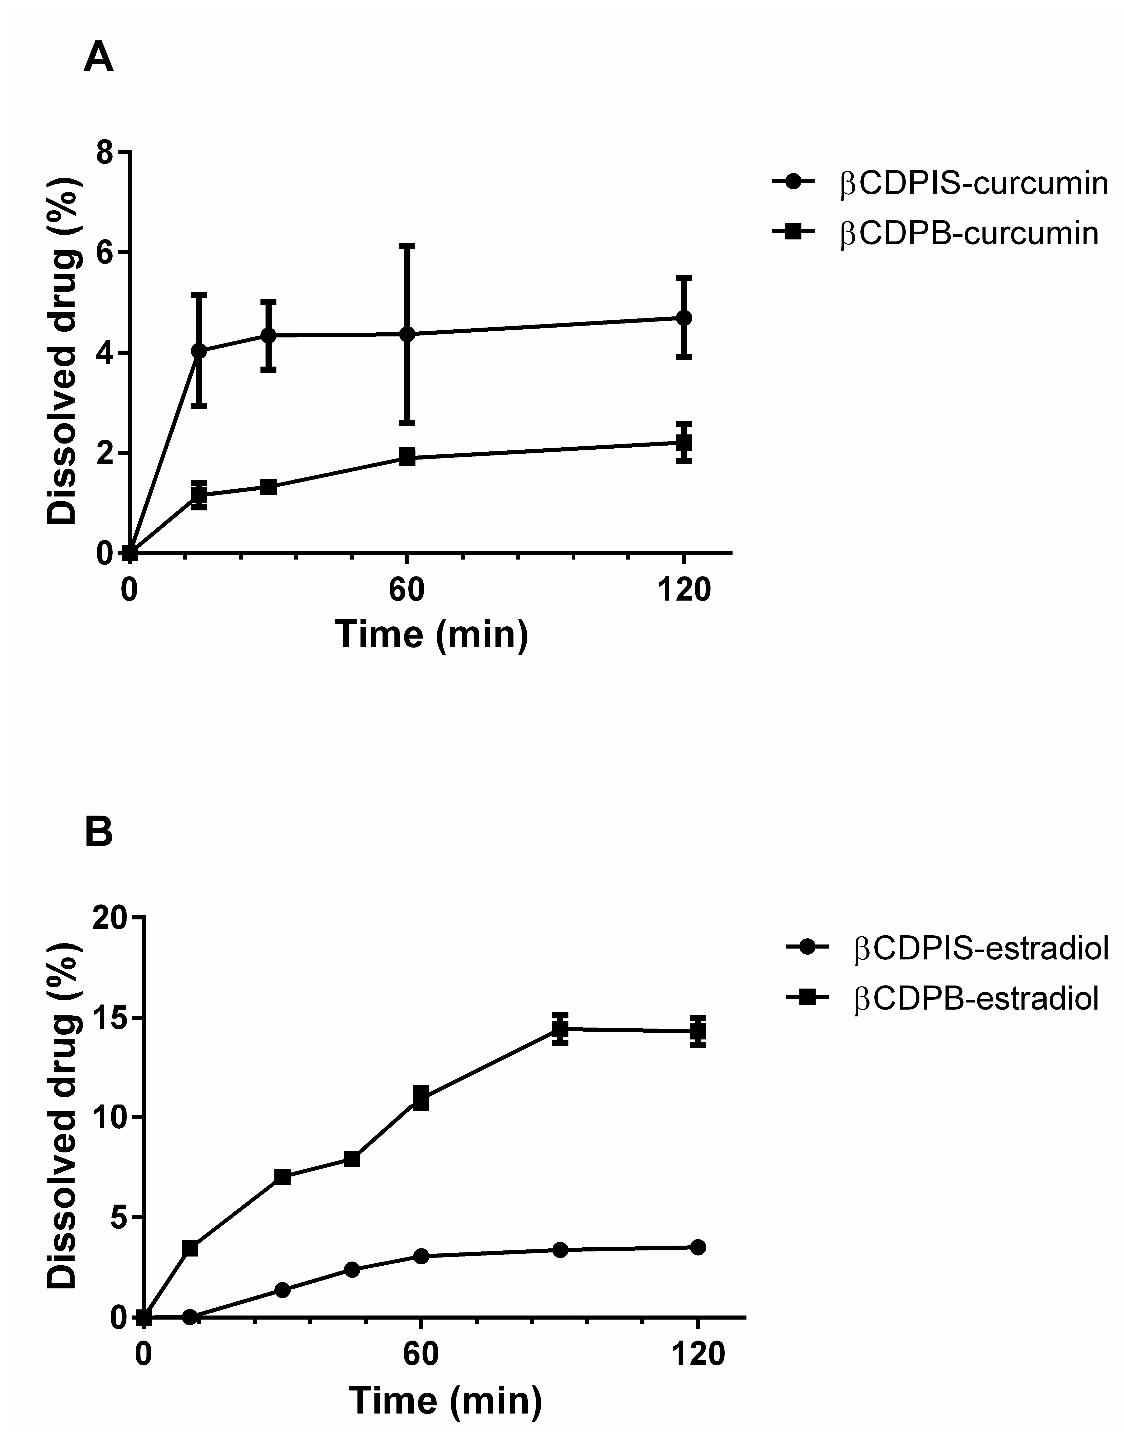
Figure 10. Dissolution profile of curcumin ( A ) and estradiol ( B ) complexes.